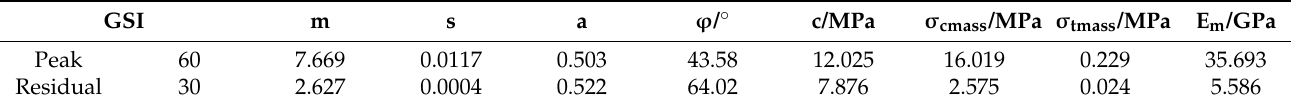
Table 5. Mechanical parameters of the rock mass.